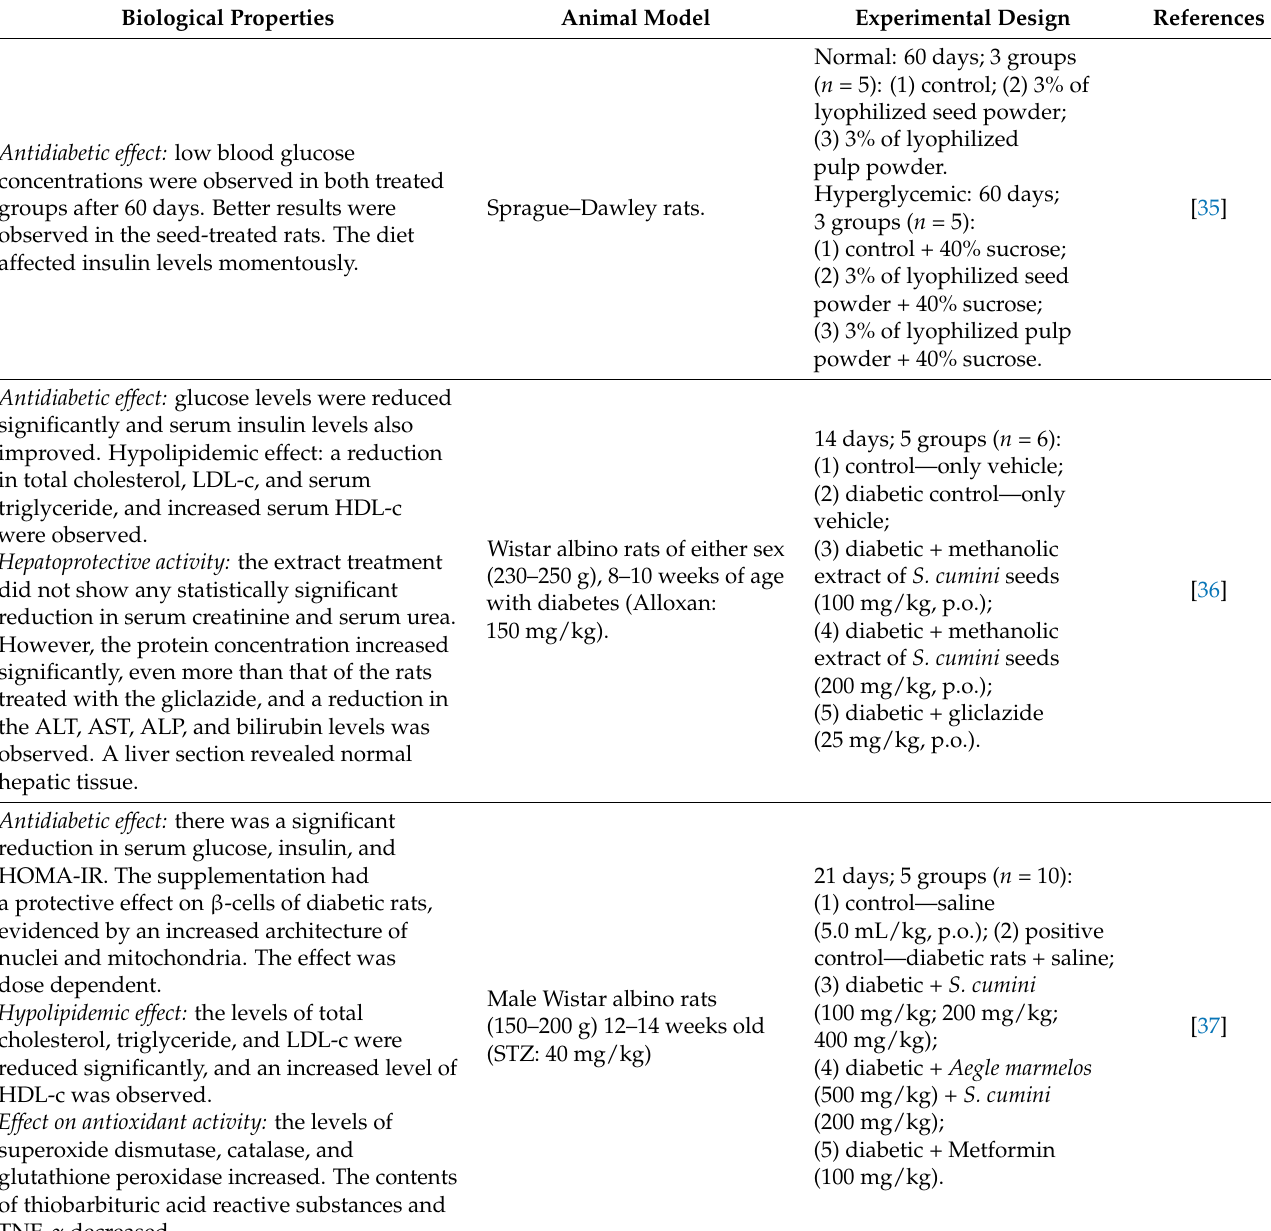
Table 2. A summary of various experimental studies on the health-beneficial effects of Jamun seeds in an animal